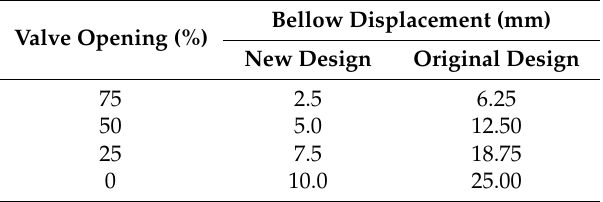
Table 3. Bellow displacement comparison of the original and new